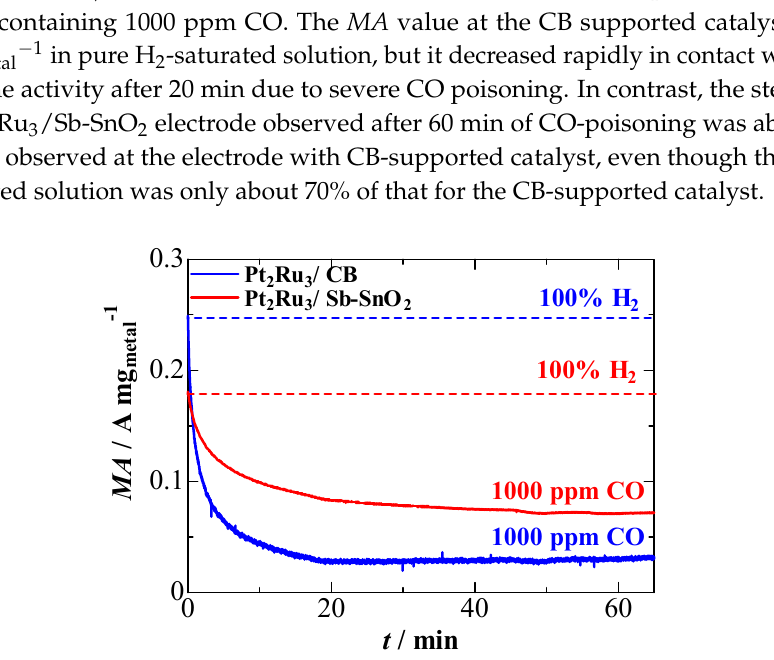
Figure 3. Change in the mass activity for the HOR (hydrogen oxidation reaction) ( MA ) at 0.02 V on Nafion-coated Pt 2 Ru 3 /CB and Pt 2 Ru 3 /Sb-SnO 2 electrodes under a flow of 0.1 M HClO 4 (linear flow rate = 10 cm · s − 1 , corresponding to a volume flow rate of 2 cm 3 · s − 1 ) saturated with H 2 (dashed lines) and 1000 ppm CO/H 2 (solid lines) at 70 °C.